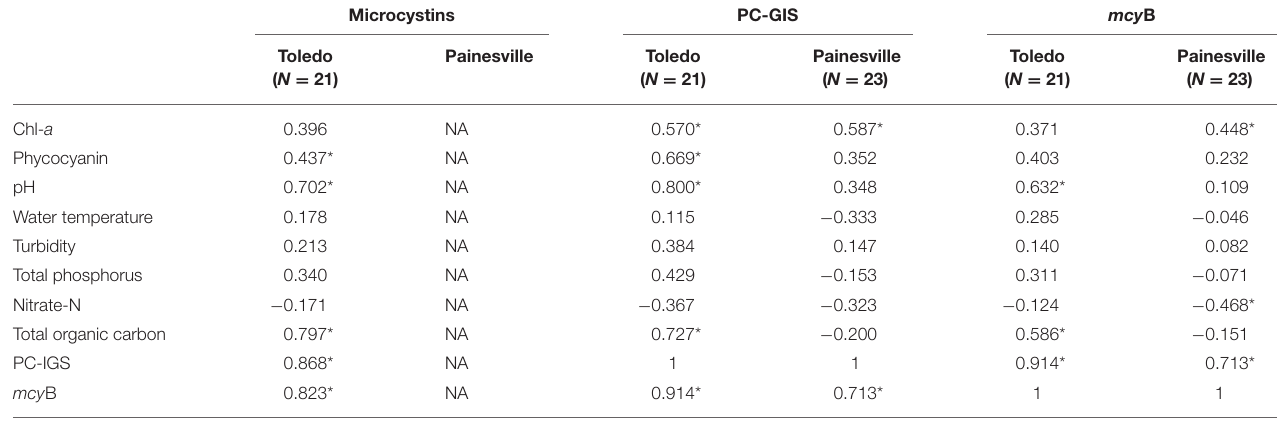
* Indicates significant with P < 0.05.